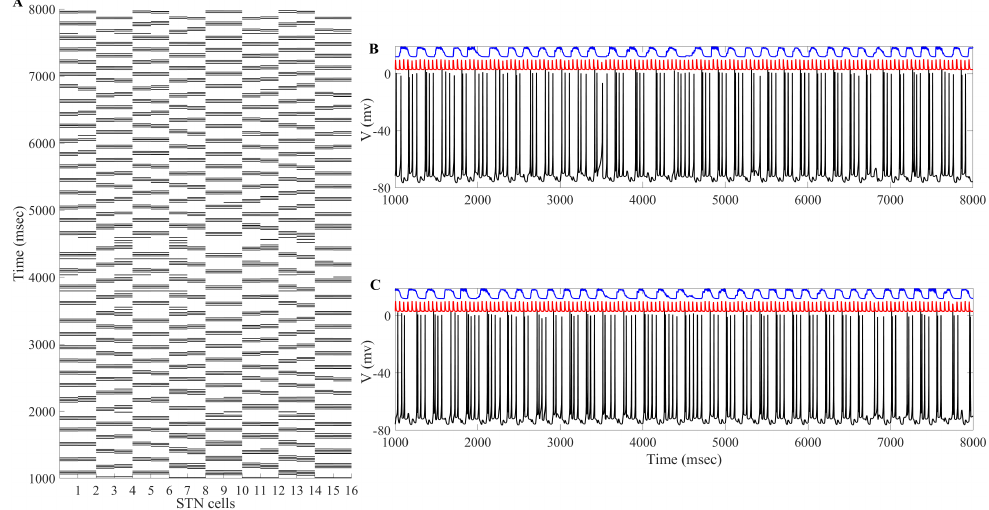
Figure 19. STN clusters in the parkinsonian network. Panel ( A ) shows that the 16 model STN neurons form two synchronized clusters. Panels ( B , C ) show the membrane potentials of the two TC neurons (bottom curve, black) responding to excitatory sensorimotor signals (middle curve, red), along with the total synaptic input the corresponding TC cell receives from eight GPi neurons (top curve,